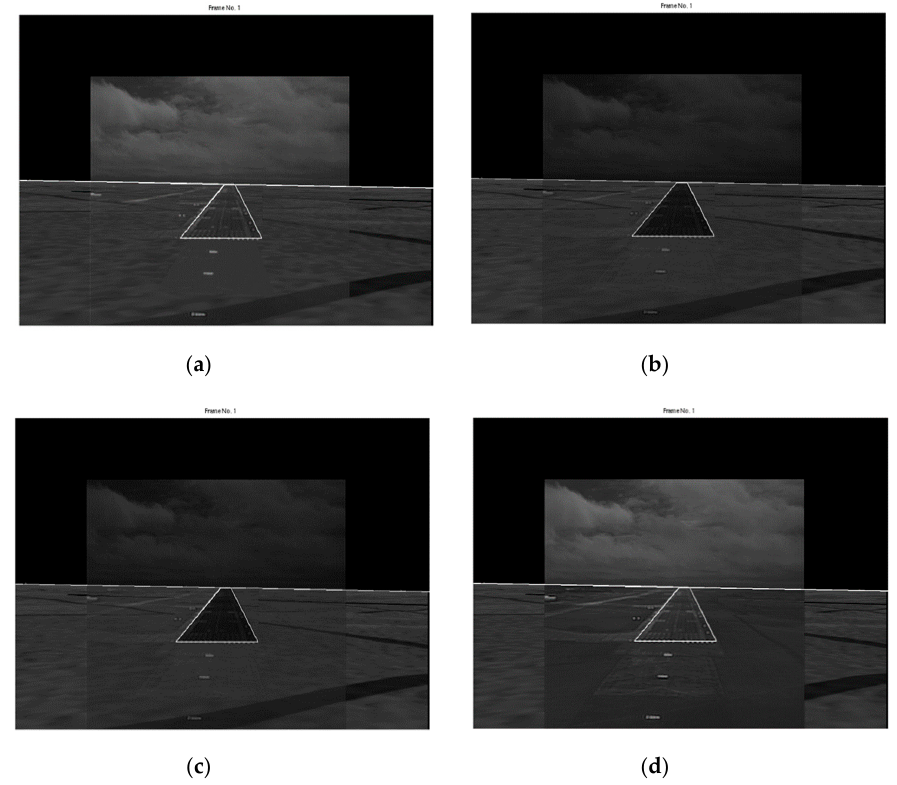
Figure 9. Fusion in severe turbulence ( k = 0.0025). ( a ) Maximum rule; ( b ) Average rule; ( c ) Mixed rule;